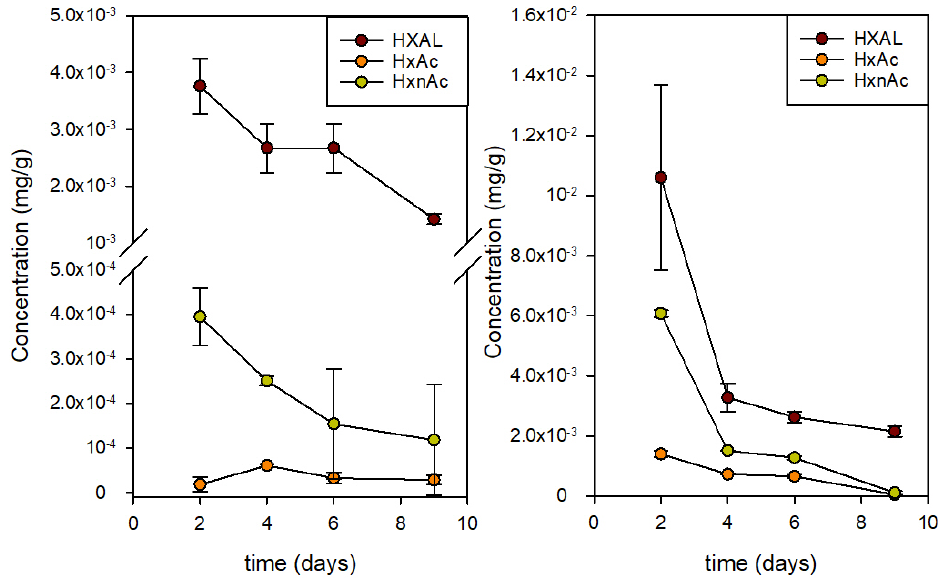
Figure 5. Concentration of trans-2-hexenal (HXAL), hexyl acetate (HxAc), and 2-hexen-1-ol acetate (HxnAc) in strawberries stored in control packages (left) and active packages (right) with 100 µL of HXAL. Table 4. Color parameters of the strawberries on days 0 and 14, L*, a*, b*, C ab *, h ab *, and ∆ E for each reference compared to the initial